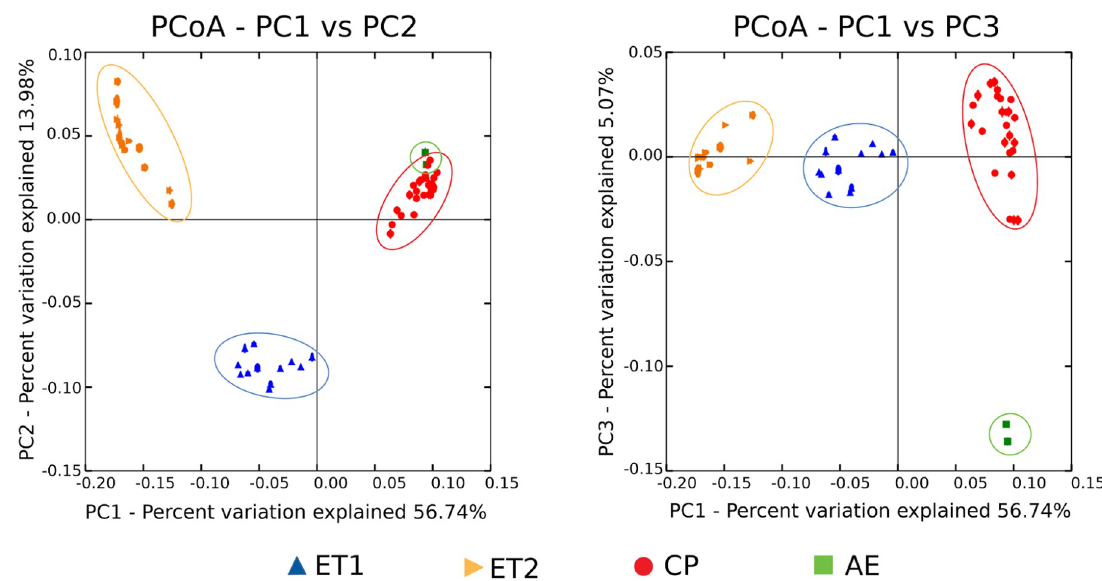
Fig 3. Principal coordinate analysis (PCoA) of unweighted UniFrac distances. Chicken cecal microbiota samples from different Argentinian farms were designated as ET1: Experimental Trial 1, ET2: Experimental Trial 2, CP: Conventional Poultry, and AE: Agroecological Farm.